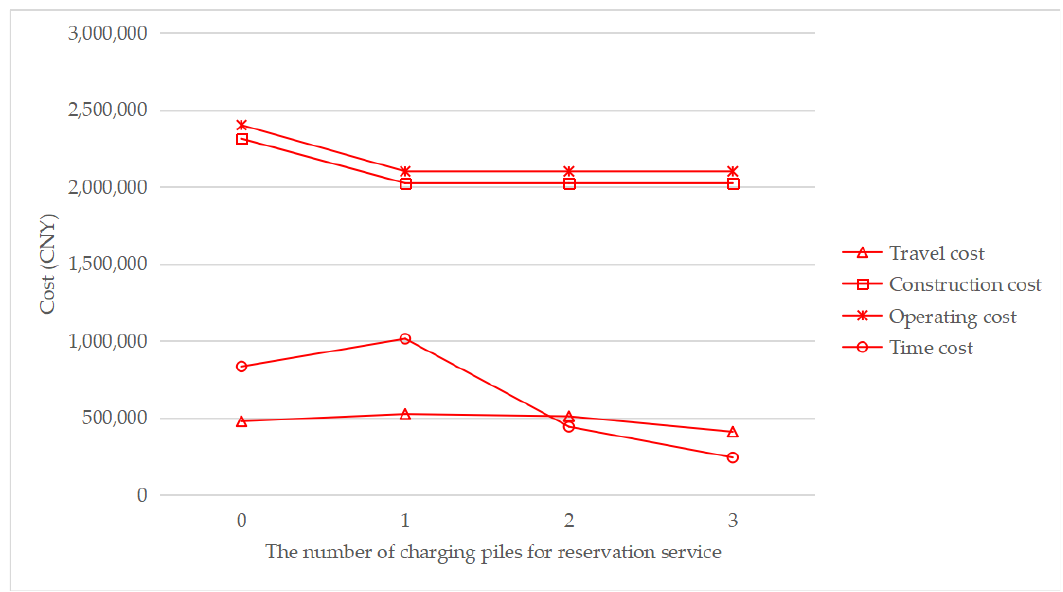
Figure 10. Cost change with a changing number of charging piles for the reservation service under 2.0 = τ .